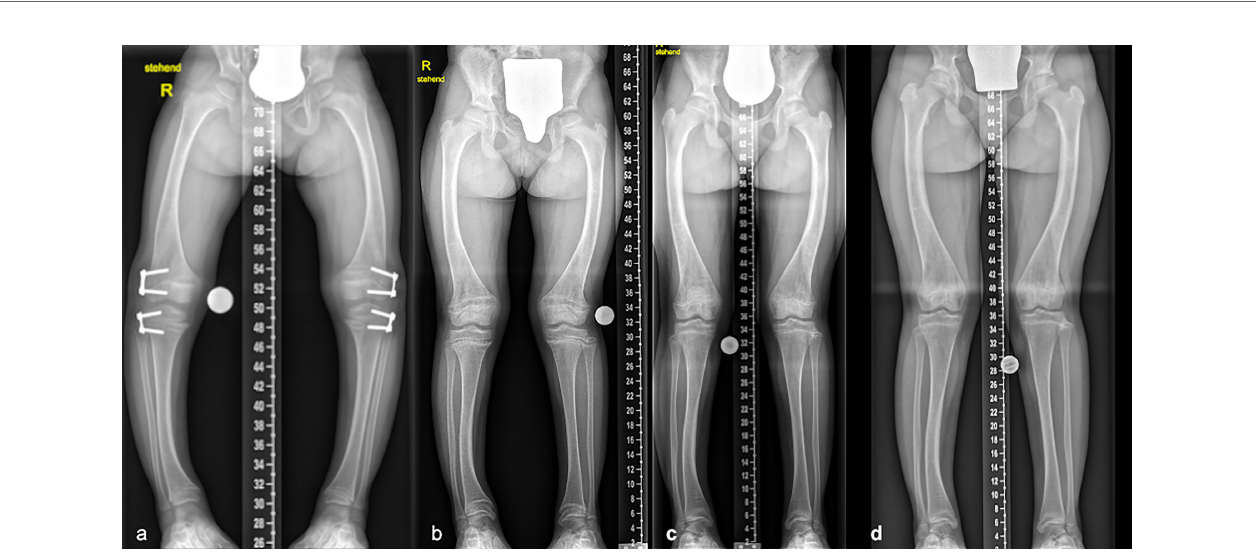
response ( Figure 9 , starting dose 0.8mg/kg, 1 year follow-up: